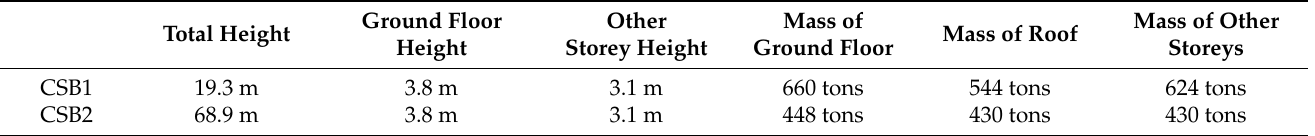
Figure 6. Structural layout (showing positions of the frame, and walls W1 and W2), structural de- tailing, and elevation of case study building CSB 2 (all dimensions are in mm). Table 2. Details of the storey height and storey masses of the case study buildings.